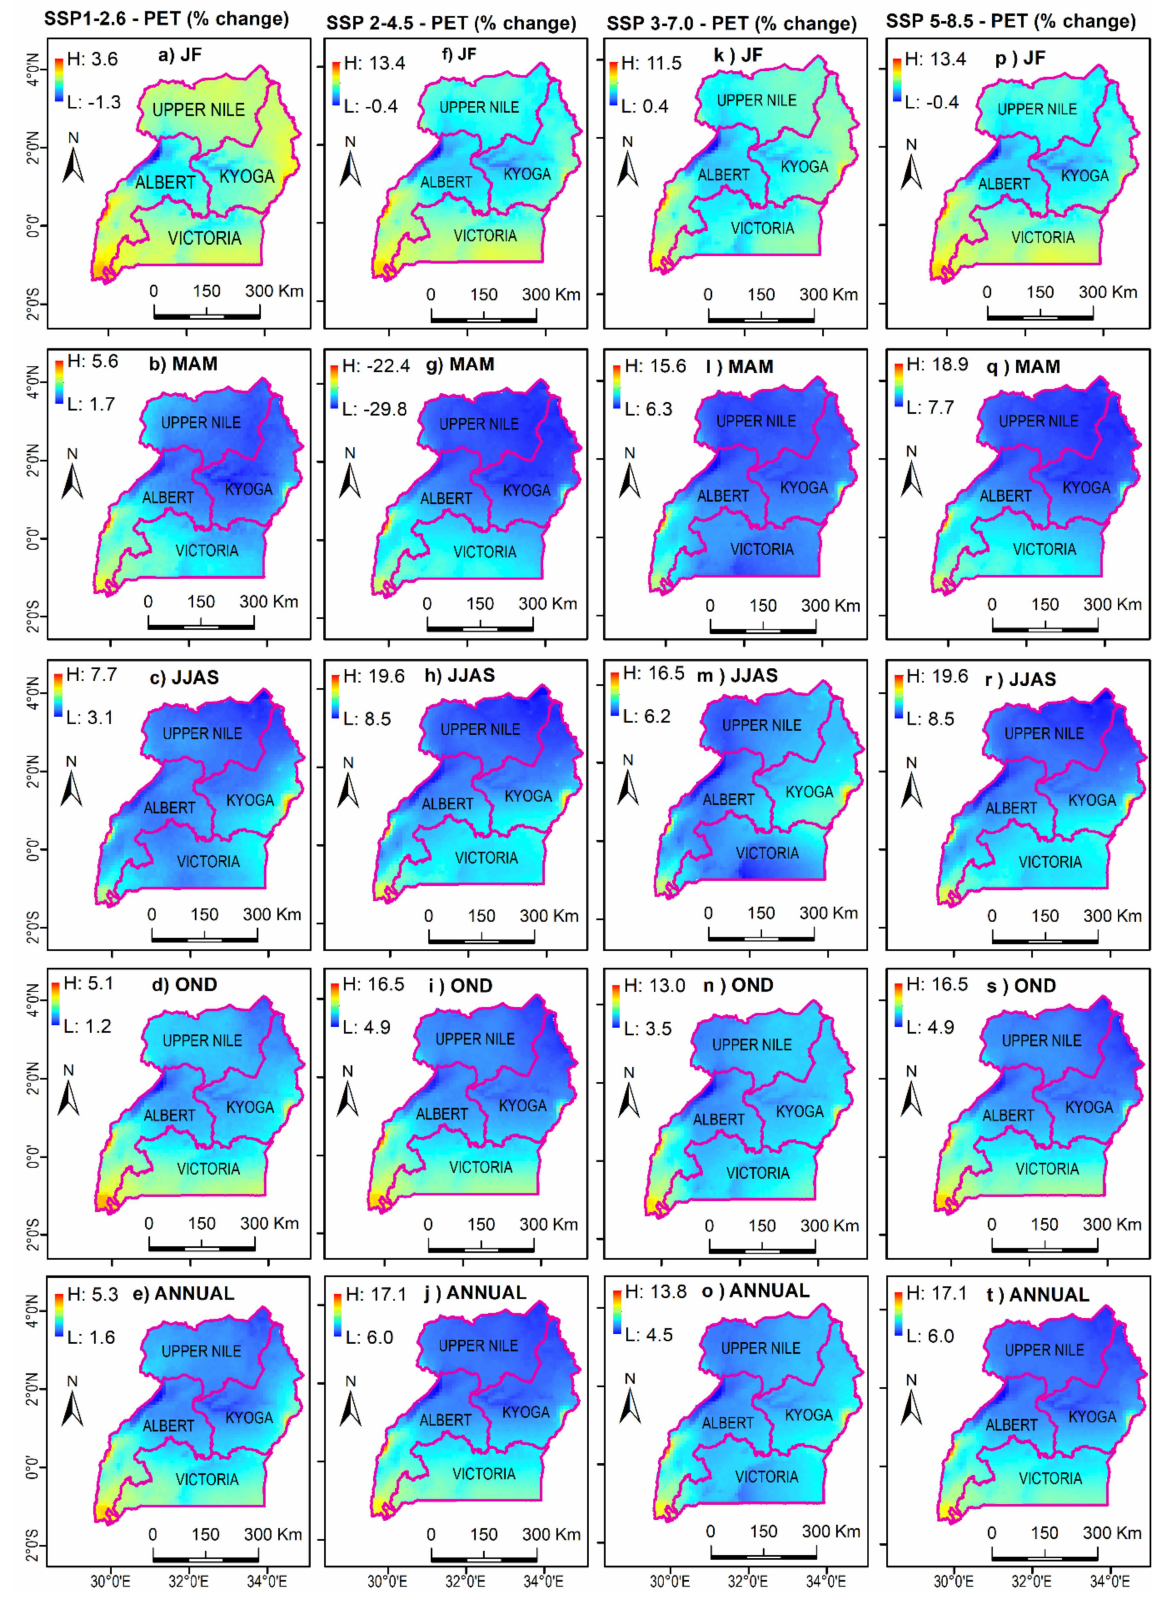
Figure A6. Percentage change in PET over the period